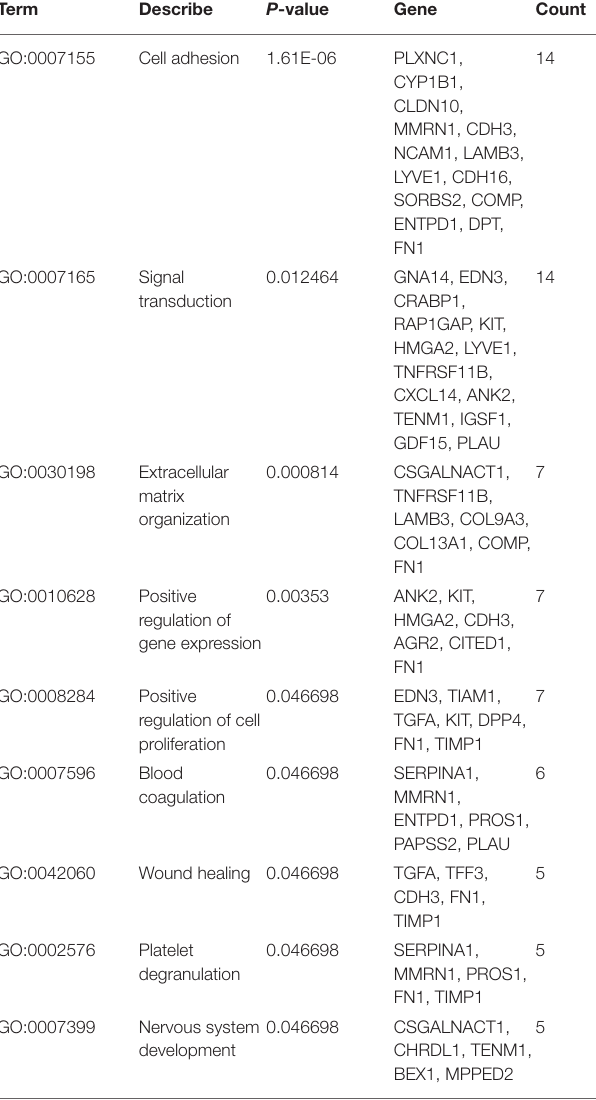
TABLE 1 | The information related to biological processes of statistical significance.